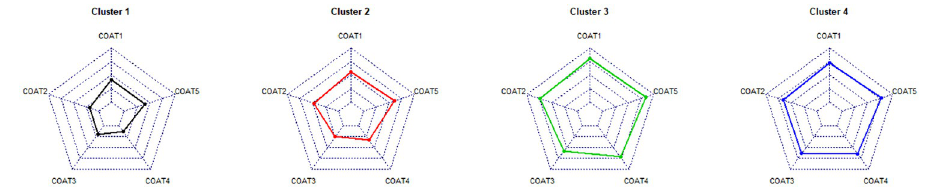
Fig 4. Summary of COAT scores among clusters. COAT 1: Frequency of cough, COAT 2: Limitation on daily activities, COAT 3: Sleep disturbance, COAT 4: Fatigue, COAT 5: Hypersensitivity to irritants.